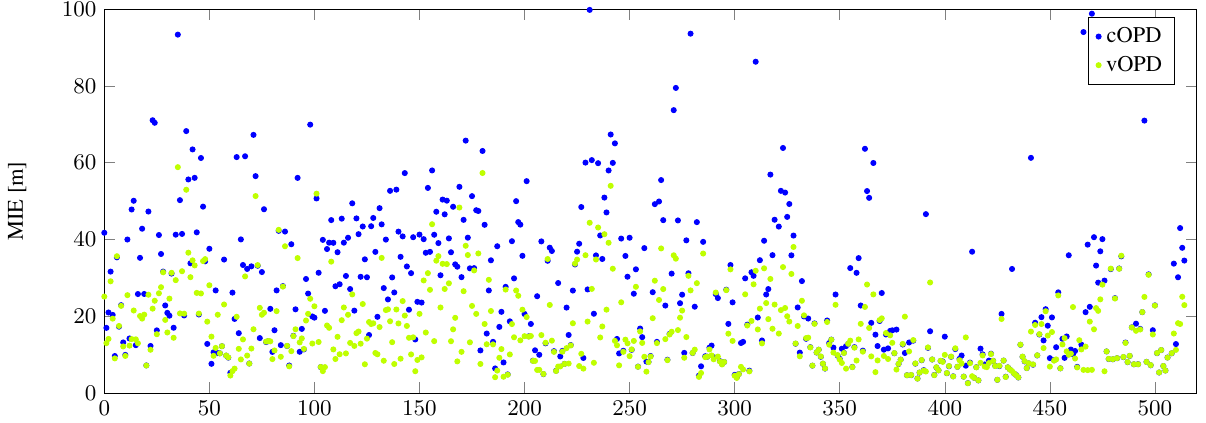
Figure 6: Mean intersection error (MIE) of 515 HRSC image strips with oscillations via bundle adjustment with a constant and a variable orientation point